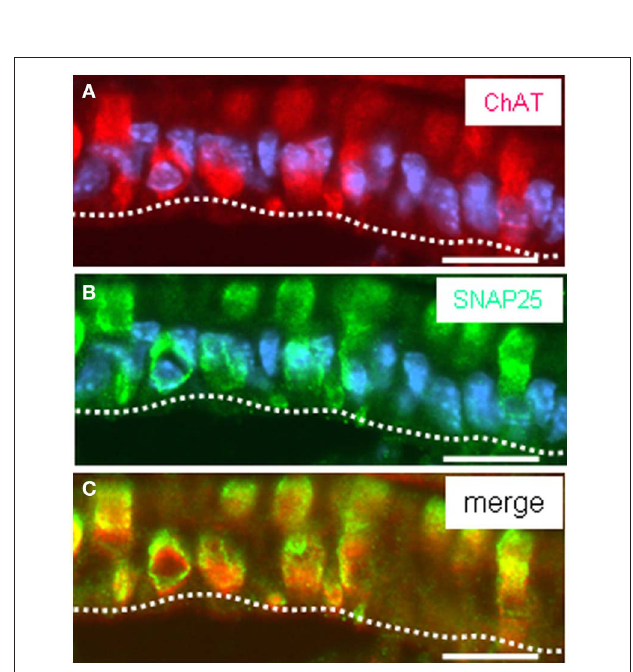
FIGURE 9 | Acetylcholine synthesizing cells express the vesicular protein SNAP25. (A–C) Assessment of SNAP25 and ChAT-immunostaining on cross sections through the corpus mucosa at fundus/corpus boundary using specific antibodies against ChAT ( red ) and SNAP25 ( green ). ChAT-immunostaining visualized clustered ChAT-expressing cells extending into the “gastric groove” built by the “limiting ridge” (A) . The SNAP25 antibody reveals a pattern of immunostaining (B) reminiscent of that of ChAT (A) . Overlay (C) of (A) and (B) clearly exposes coexpression of ChAT and SNAP25 in all stained corpus mucosal cells underneath the “limiting ridge.” Sections were counterstained with DAPI ( blue ). Scale bars : (A–C) = 20 μ